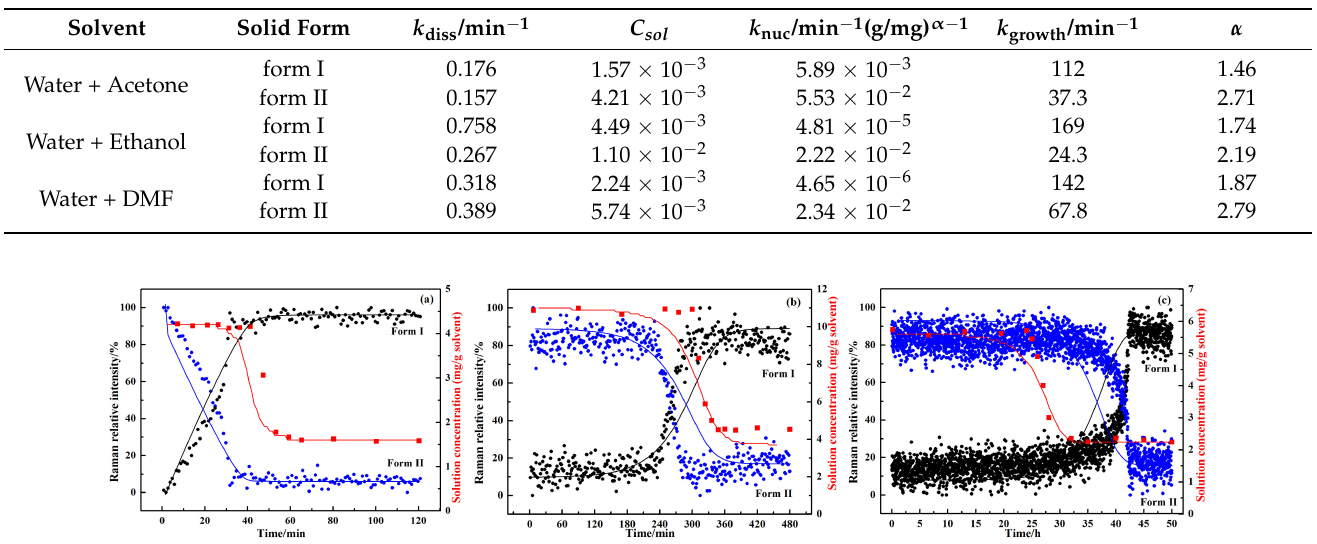
Table 2. Model parameters for the solution-mediated polymorphic transformation of L-carnosine in different solvent mixtures.